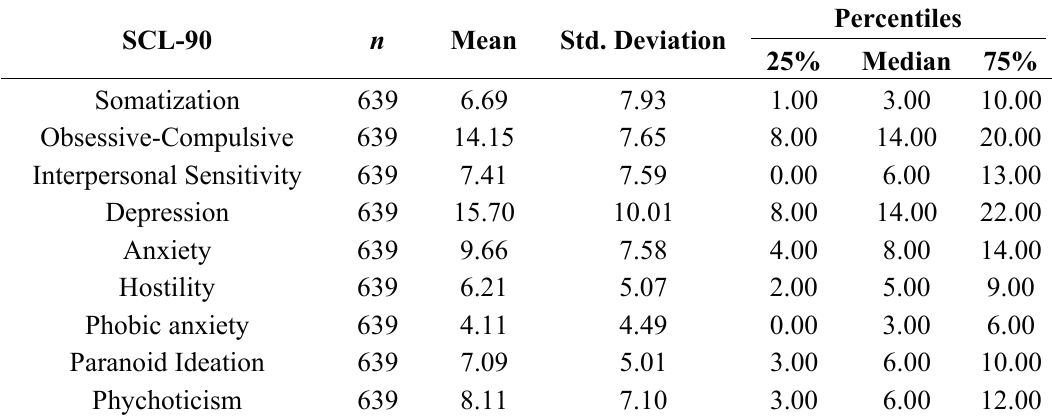
Table 7. Descriptive statistics for SCL-90